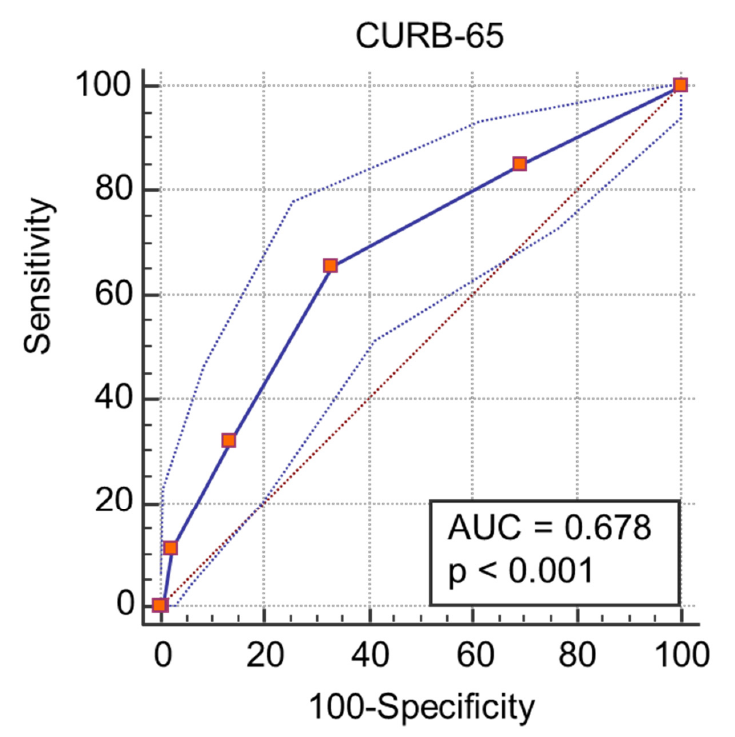
Figure 6. ROC curve and AUC values for CURB-65 score and ICU admission. Table 5. Sensitivity, specificity, predictive positive, and negative values of GOL2DS score in predicting ICU admission.